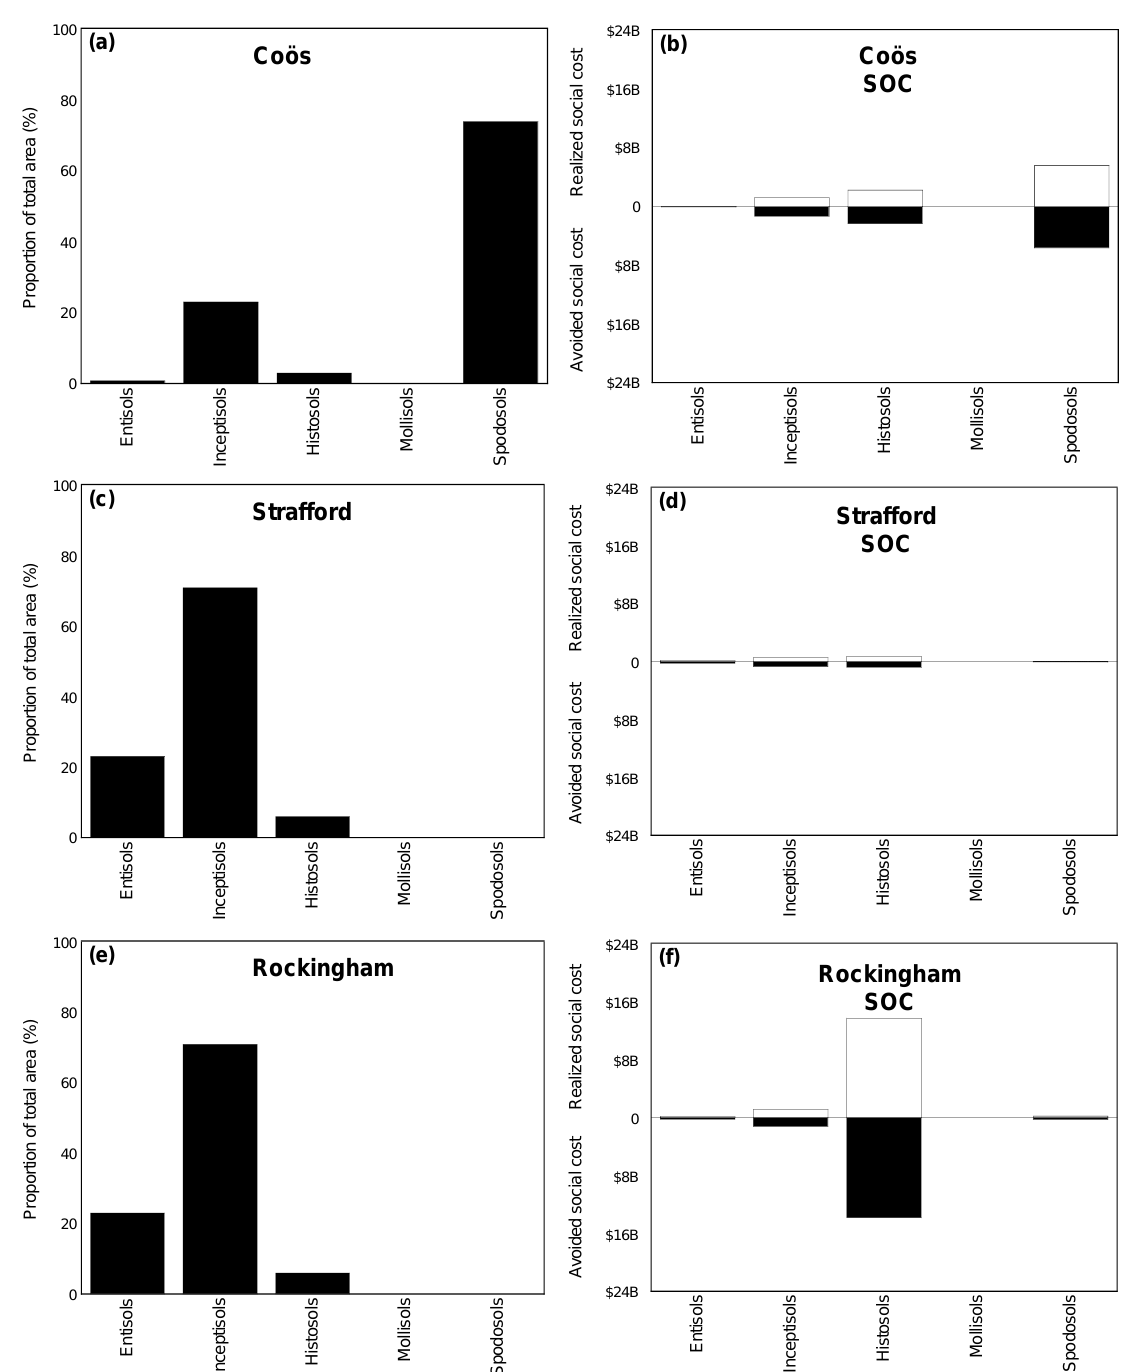
Figure 4. Diagram showing how the “ portfolio-effect ” and “ distribution-effect ” of pedodiversity can vary within the state by soil order: ( a ) pedodiversity by area of soil order; ( b ) monetary value of soil organic carbon (SOC) storage or potential cost if all SOC is released as CO 2 emissions, ( c ) similar value or potential cost associated with soil inorganic carbon (SIC), ( d ) similar value or potential cost associated with total soil carbon (TSC). Monetary valuation is based on soil C in the upper 2-m depth and a social cost of CO 2 emission of USD 46 (USD) per metric ton of CO 2 [19]. Note: B = billion = 10 9 .